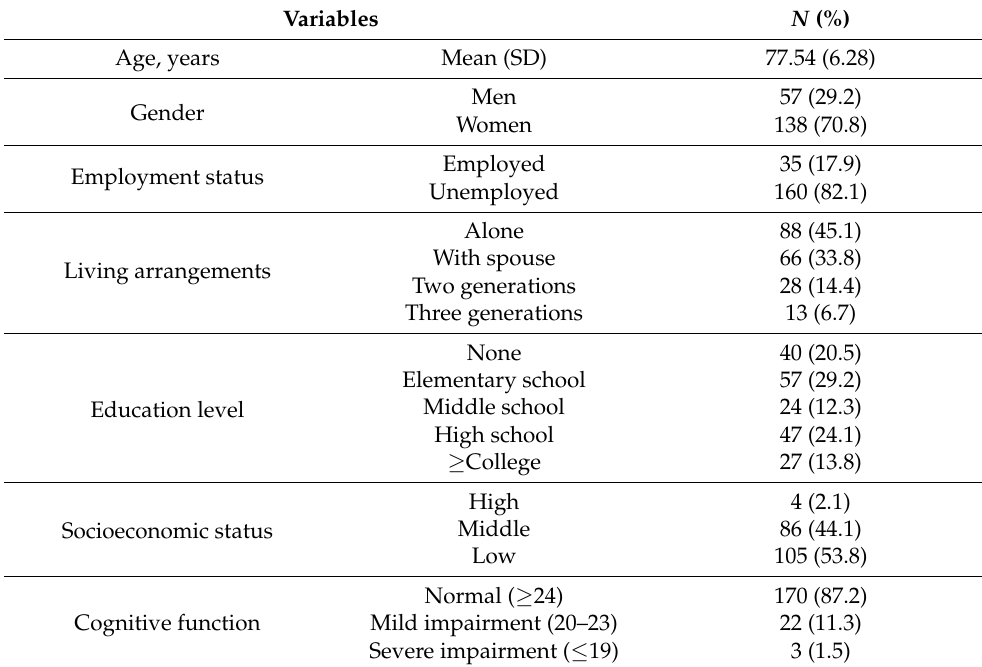
Table 1. Participants’ general characteristics ( N =